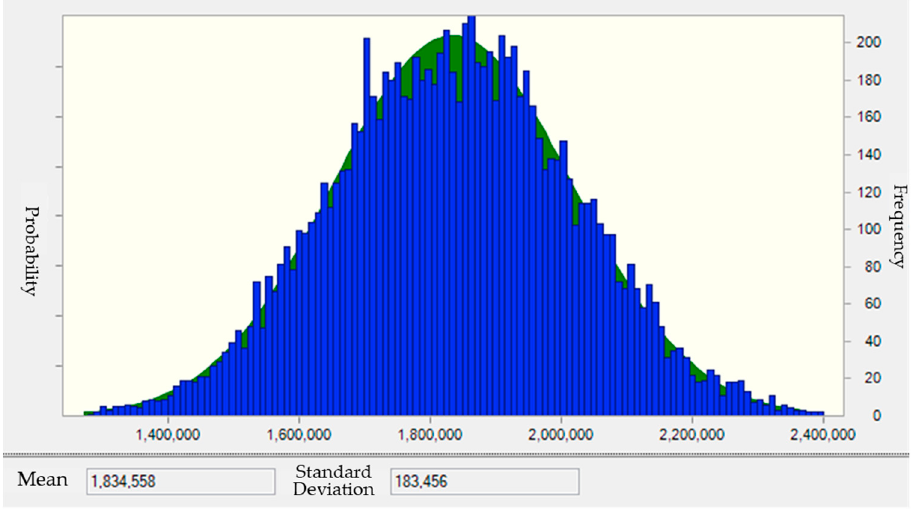
Figure 7. Probability distribution for residential facility CAPEX (normal distribution).